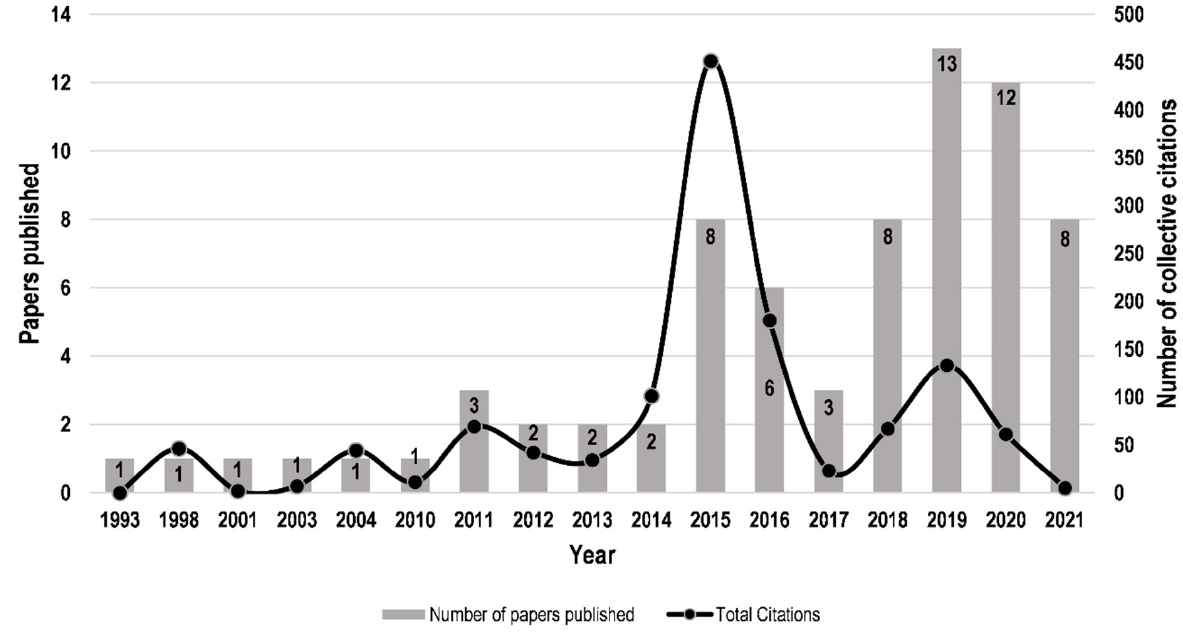
Figure 4. Collective citations of total published papers against each year between 1993–2021.